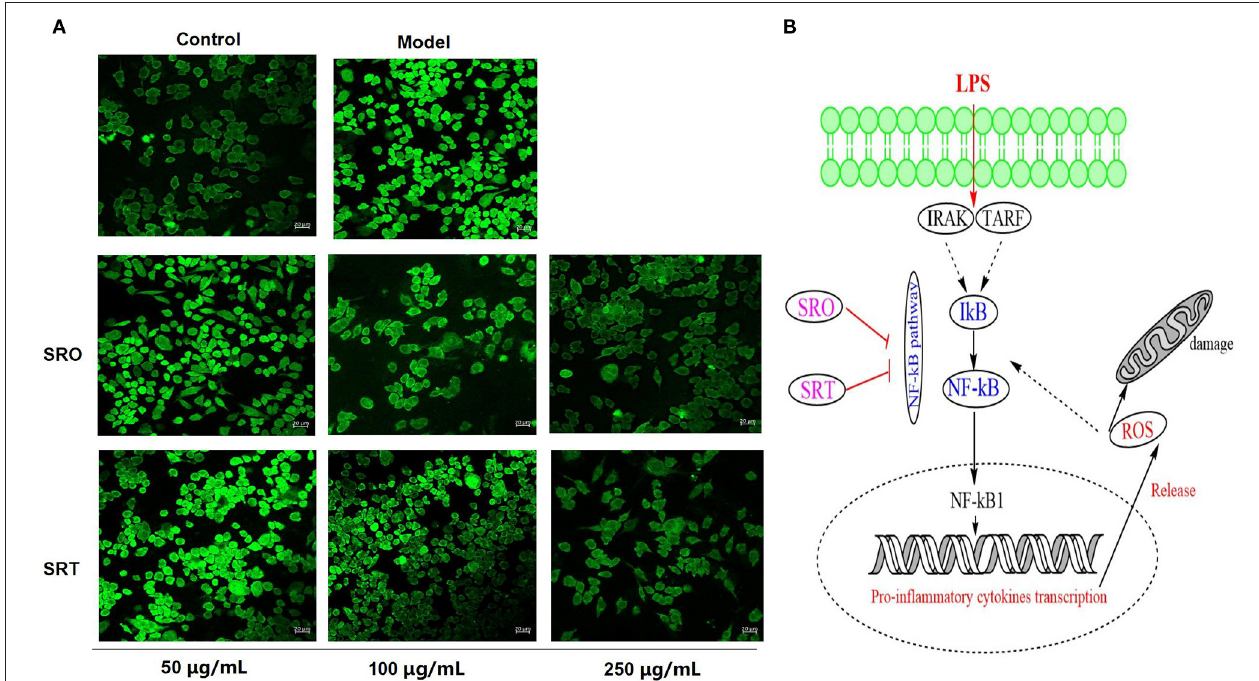
FIGURE 4 | The fluorescence for measuring the cellular ROS production (A) and the NF- κ B signaling pathway (B) of RAW264.7 cells treated by SRO and SRT.